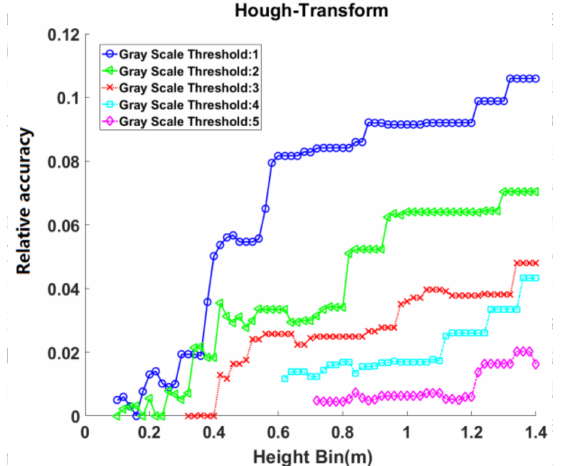
Figure 12. The relative accuracy of Hough-Transform under different height bins and gray scale thresholds in single-scan mode of the natural secondary forest.